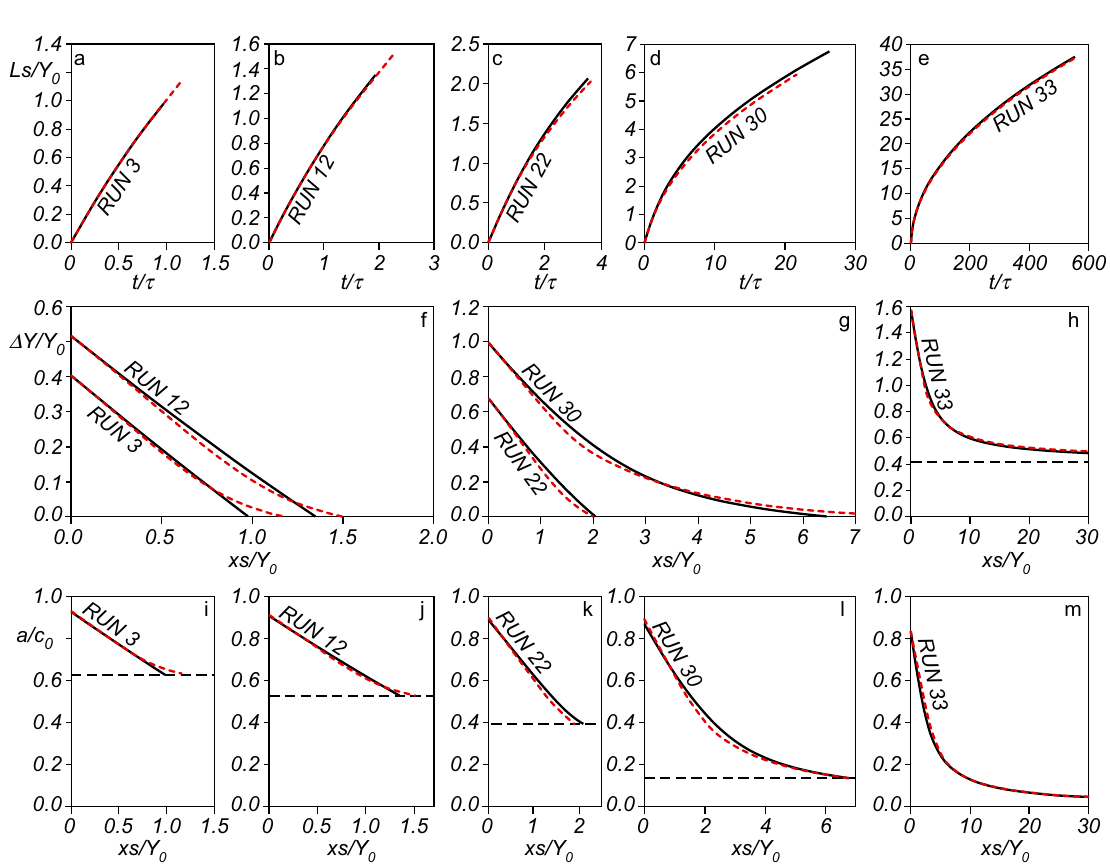
Figure 7. Comparison between the 0D model (black solid lines) and the numerical solution of the Shallow Water Equations using the Finite Volumes model (red dashed lines), in terms of dimensionless position of the front to dimensionless time ( a – e ), and dimensionless front height ( f – h ) and surge celerity ( i – m ) to dimensionless position of the front; run 3 ( s = 0.0002, Y 0 = 0.084 m, U 0 = 0.34 m/s, F 0 = 0.37), run 12 ( s = 0.0005, Y 0 = 0.102 m, U 0 = 0.47 m/s, F 0 = 0.47), run 22 ( s = 0.001, Y 0 = 0.058 m, U 0 = 0.46 m/s, F 0 = 0.61), Run 30 ( s = 0.0022, Y 0 = 0.037 m, U 0 = 0.52 m/s, F 0 = 0.87), and run 33 ( s = 0.0052, Y 0 = 0.011 m, U 0 = 0.43 m/s, F 0 = 1.31). Horizontal dashed lines denote the theoretical limit for a stationary jump (panel h , Equation (14) with F S = F 0 ) and for an infinitesimal perturbation (panels i – l , a = c 0 − U 0 , i.e., a / c 0 = 1 − F 0 ).